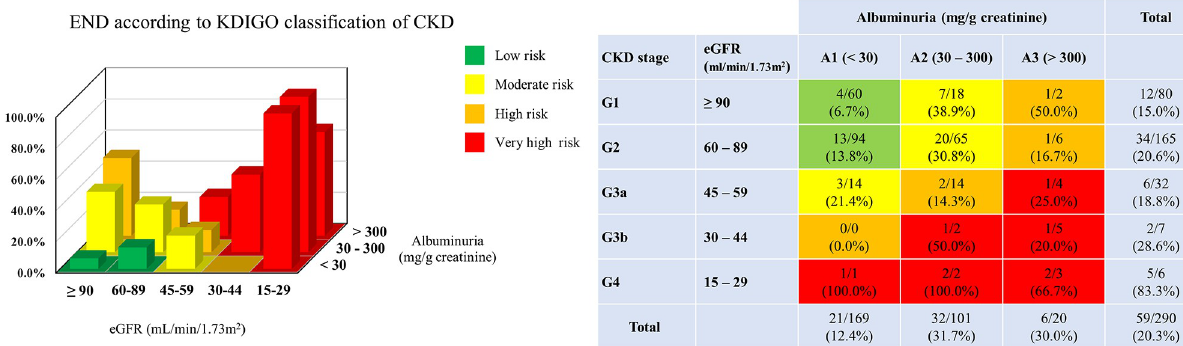
Fig 1. Distribution of the percentage of END patients according to KDIGO classification. Low-risk group is green, moderate-risk group is yellow, high-risk group is dark orange, and very-high-risk group is red. CKD stage 5 (eGFR < 15 mL/min/1.73m 2 ) was not presented in this figure, since all patients with CKD stage 5 were on hemodialysis. END, early neurological deterioration; KDIGO, Kidney Disease Improving Global Outcome; CKD, chronic kidney